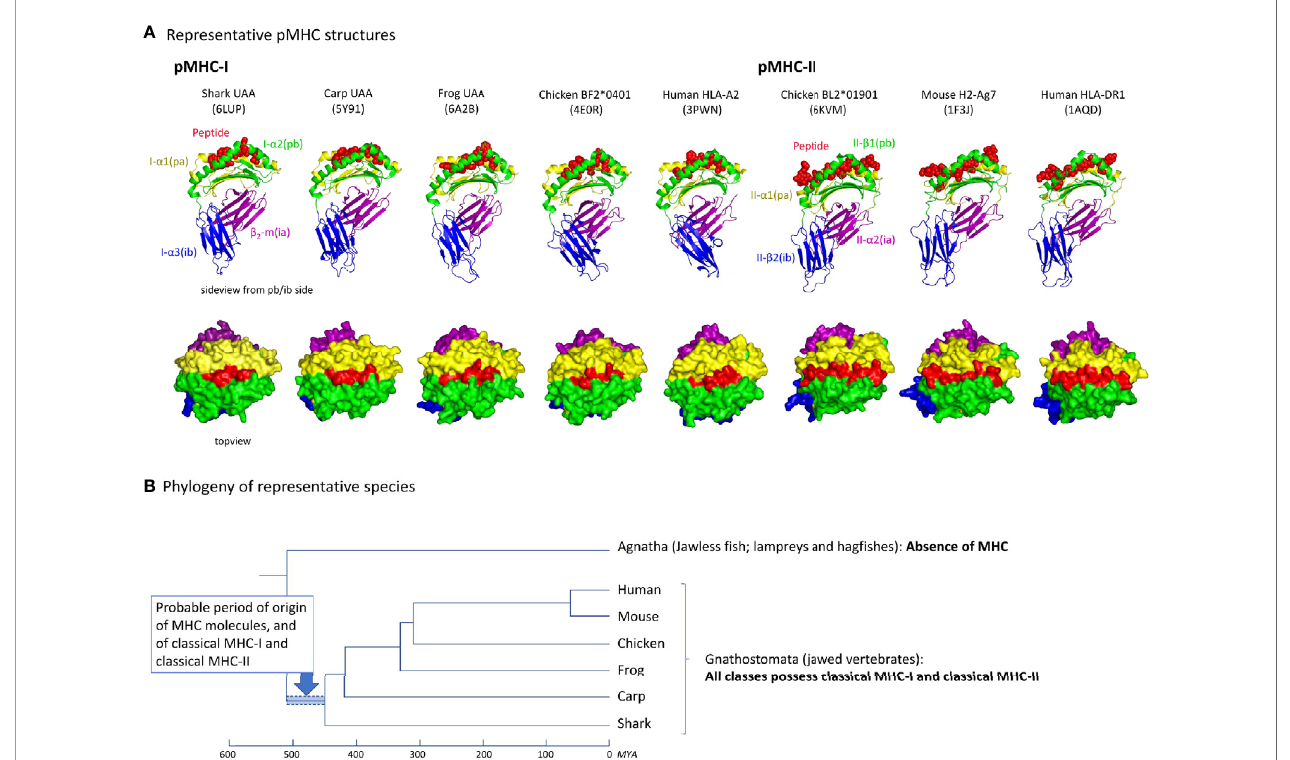
FIGURE 2 | (A) Representative pMHC-I and pMHC-II structures of different species. PDB accession numbers are between brackets. The top row shows side views, with the MHC molecules in cartoon format and the peptide in spheres format. The bottom row shows top views, in surface format. (B) Cladogram showing the phylogeny of the species shown in (A) (47, 48). Because in Agnatha no MHC genes are found and all classes of Gnathostomata possess both classical MHC-I and MHC-II, it can be assumed that MHC genes emerged and differentiated into classical MHC-I and MHC-II in the period highlighted by the blue bar. MYA, million years